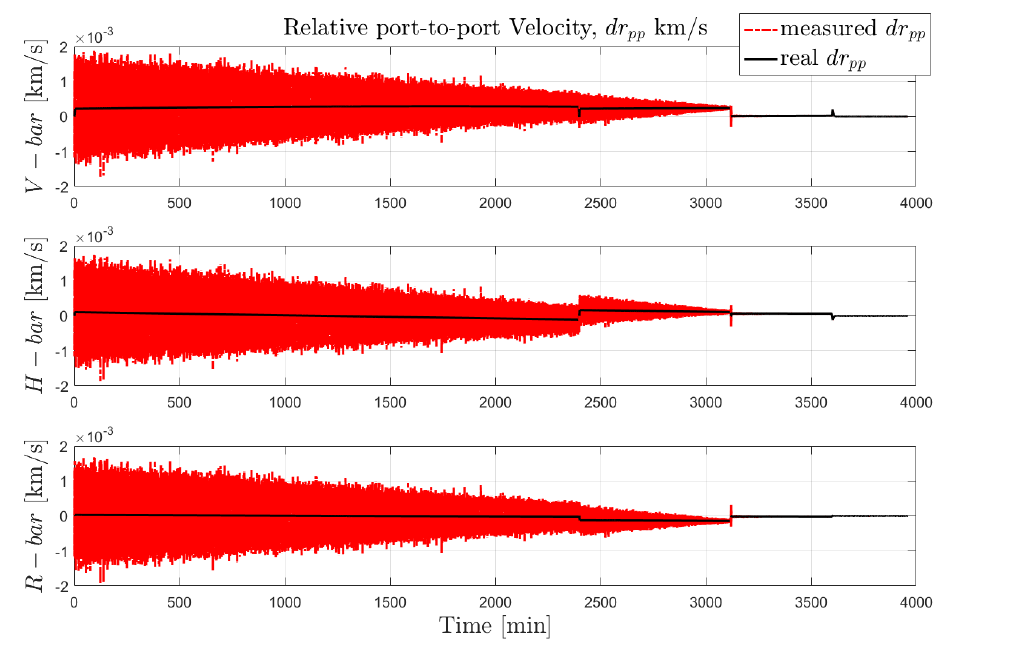
Figure 29. Relative rendezvous